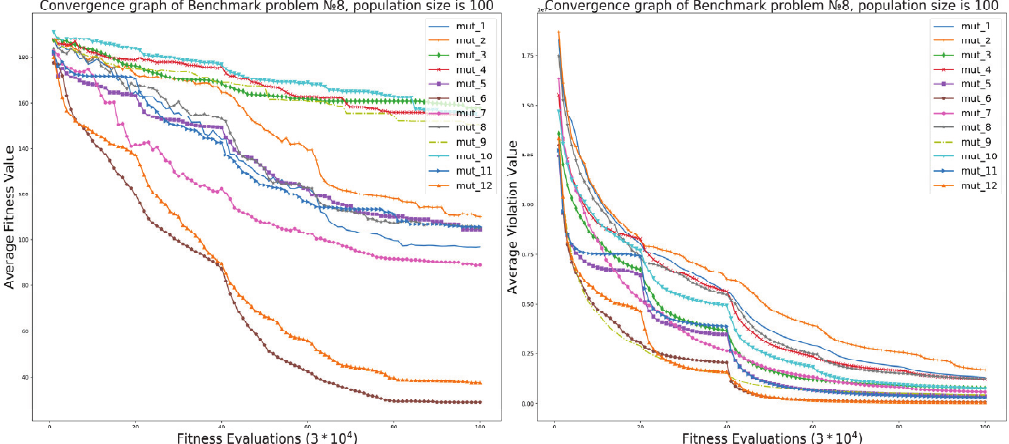
Figure 19. The performance of iCC framework on cLSGO benchmark Problem 8.